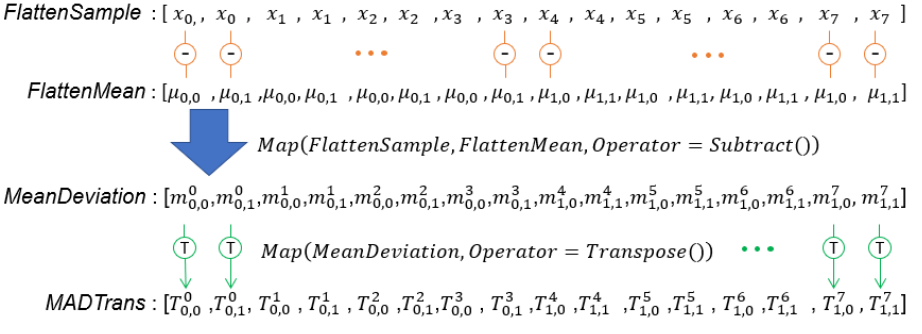
Figure 10. Illustration of computation of mean deviations and the transpose of mean deviations. m k is the mean deviation computed from the mean vector of the j th Gaussian component in the i th set and the k th sample.